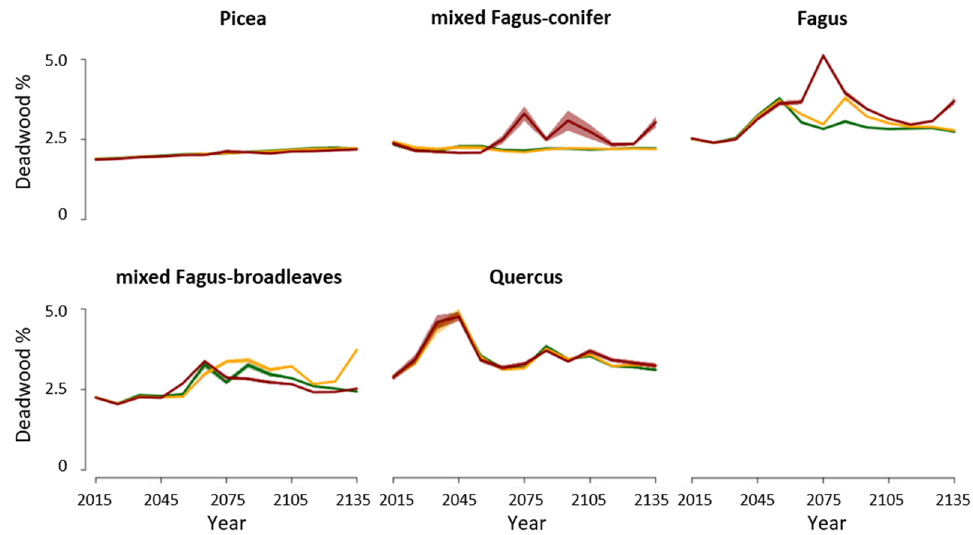
Figure 7. Percentage dead biomass relative to total biomass in the different forest types. Shaded areas indicate 95% confidence interval for every decade and climate change scenario: RCP 2.6 (green), RCP 4.5 (orange) and RCP 4.5 (red).